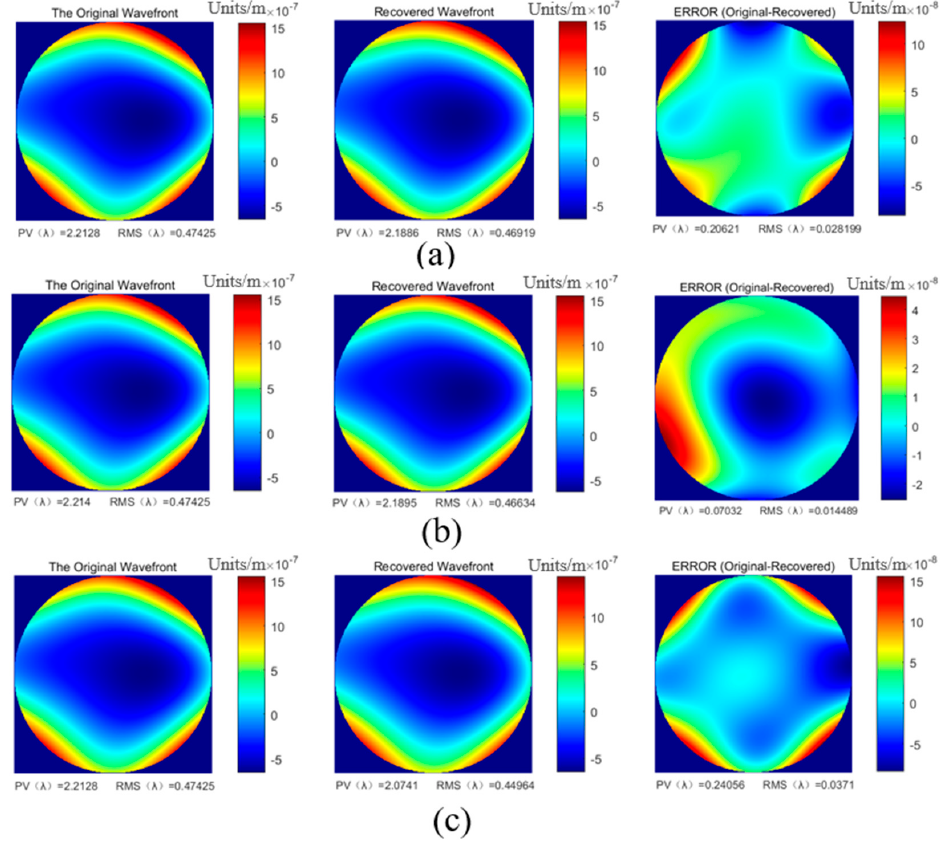
Figure 6. Simulation example of wavefront reconstruction: ( a ) hexagonal arrangement of 19 lenses; ( b ) 8 × 8 lens array; ( c ) 5 × 5 lens array.